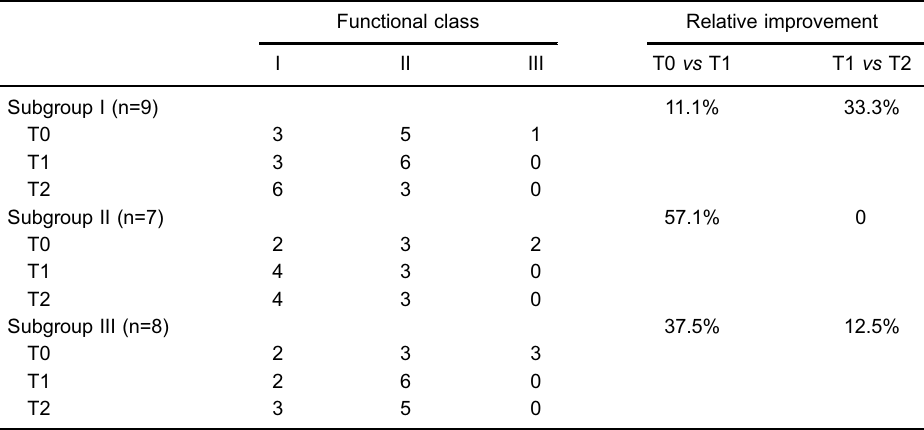
Table 2. Functional class at evaluation periods for the 3 subgroups and the relative improvement of functional class between evaluation